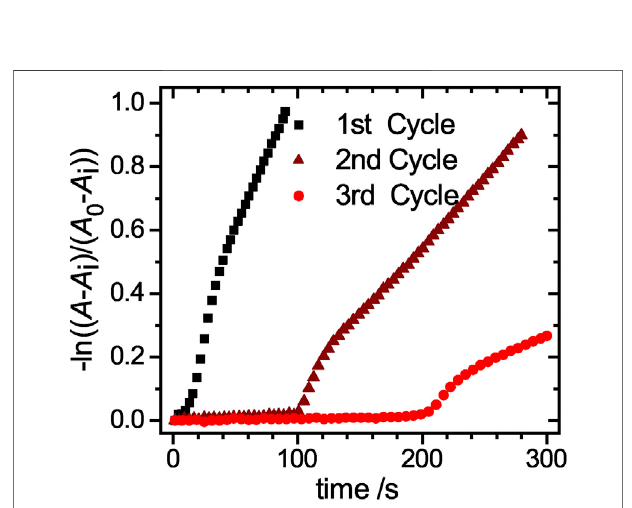
FIGURE 7 | Magni fi ed view of the linearized absorbance decay at a wavelength of 400 nm for the three cycles of the free hybrid system reactions. The three distinct regions of the catalytic reaction can be clearly identi fi ed.